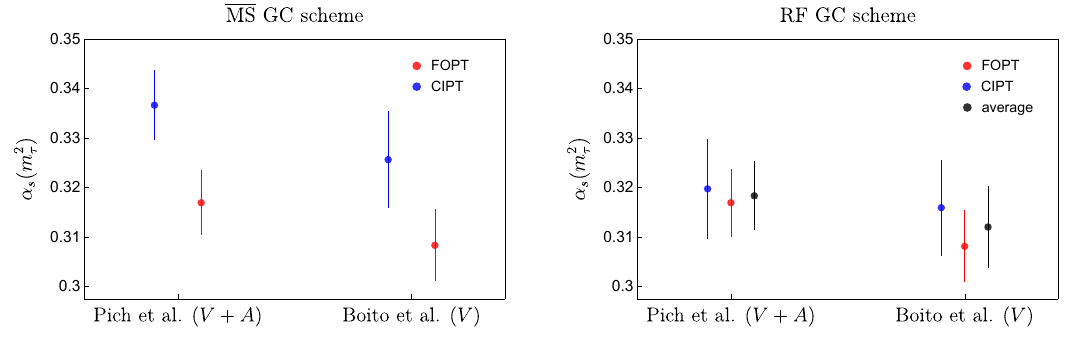
Figure 3 . Left panel: results for α s ( m 2 ) in FOPT (red) and CIPT (blue) in the MS GC scheme, τ following the strategies of ref. [11] (Pich et al.), based on the tOPE strategy applied to the V + A ALEPH data [33], and ref. [12] (Boito et al.), based on the DV-model strategy applied to the new vector spectral function of ref. [12]. Right panel: results for α s ( m 2 ) in FOPT (red) and CIPT τ (blue) and their average (black) in the RF GC scheme for the same analysis set-ups. The substantial reduction in the discrepancy between FOPT and CIPT result is clearly